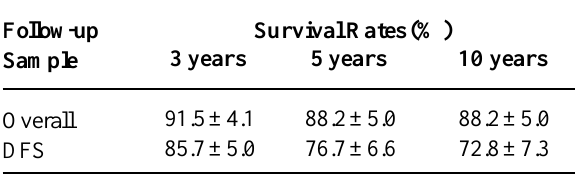
Table 2 – Overall and disease-free survival (DFS) rates.